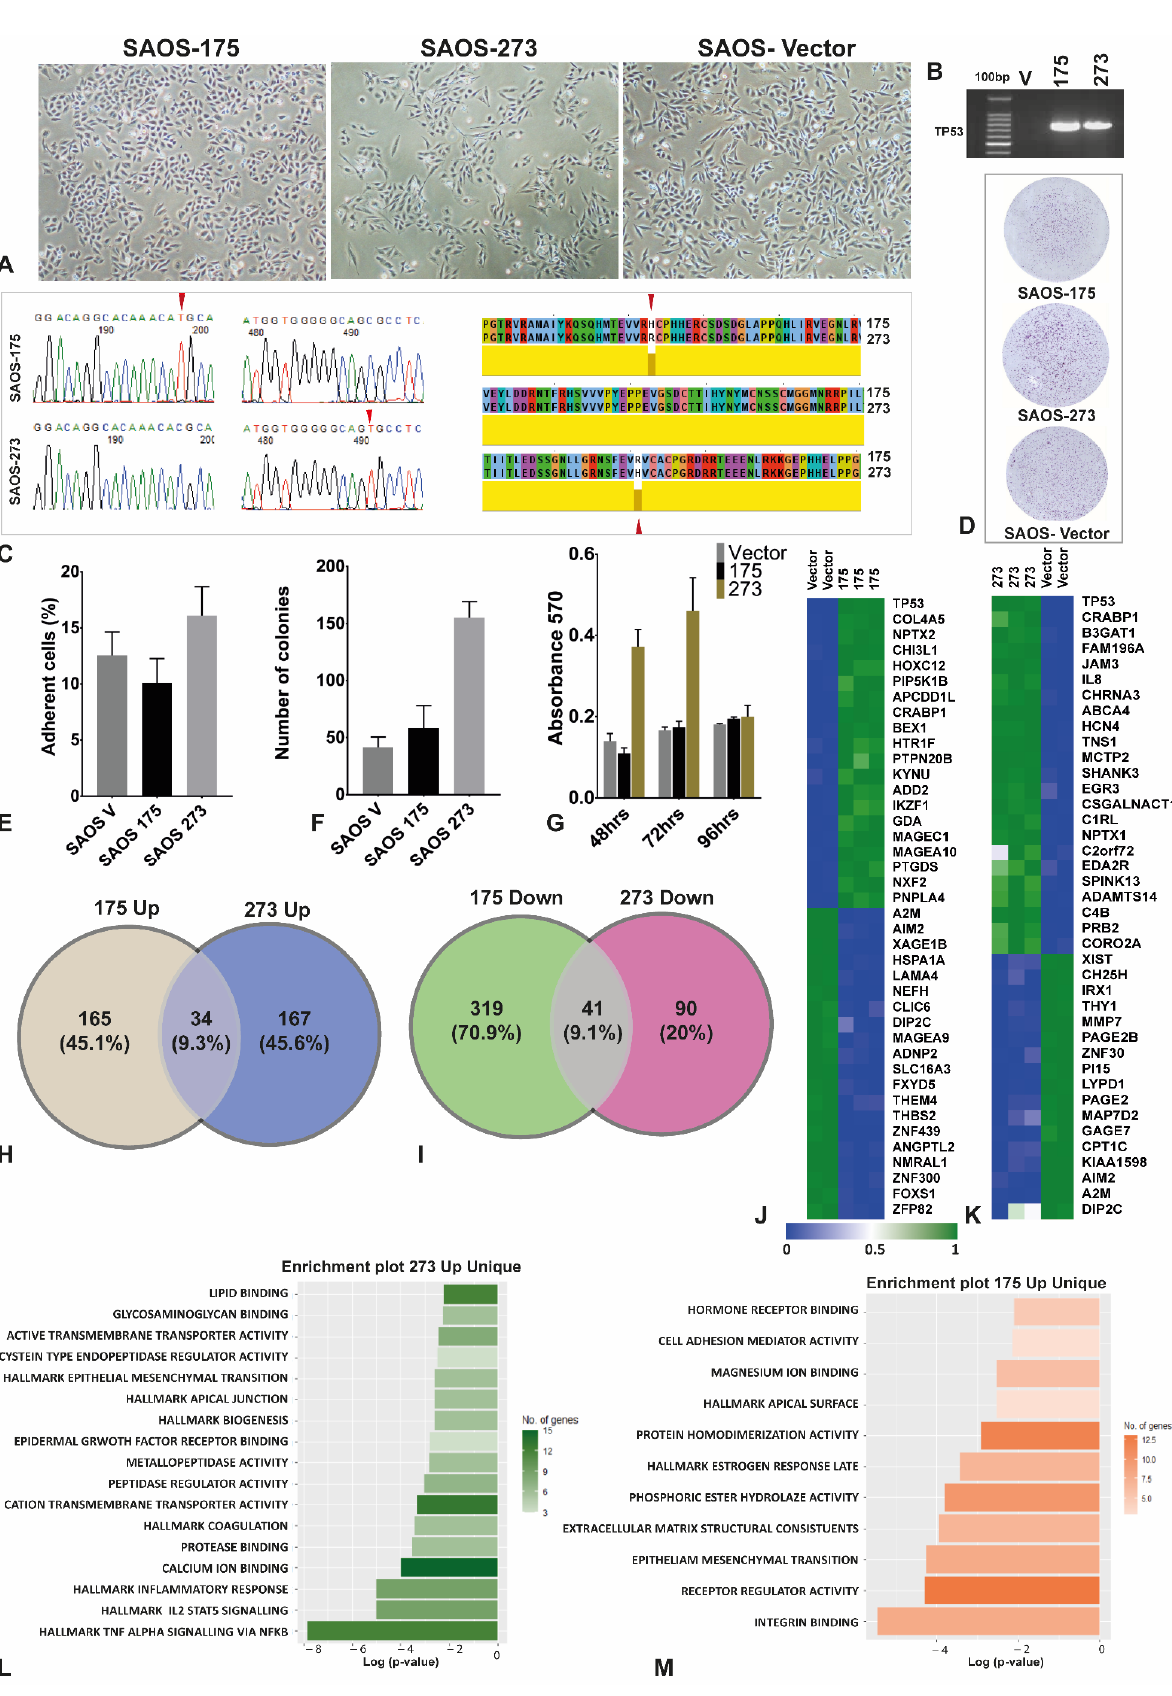
Figure 1. SaOS-p53 mutants showed significant differences at the phenotypical, functional,